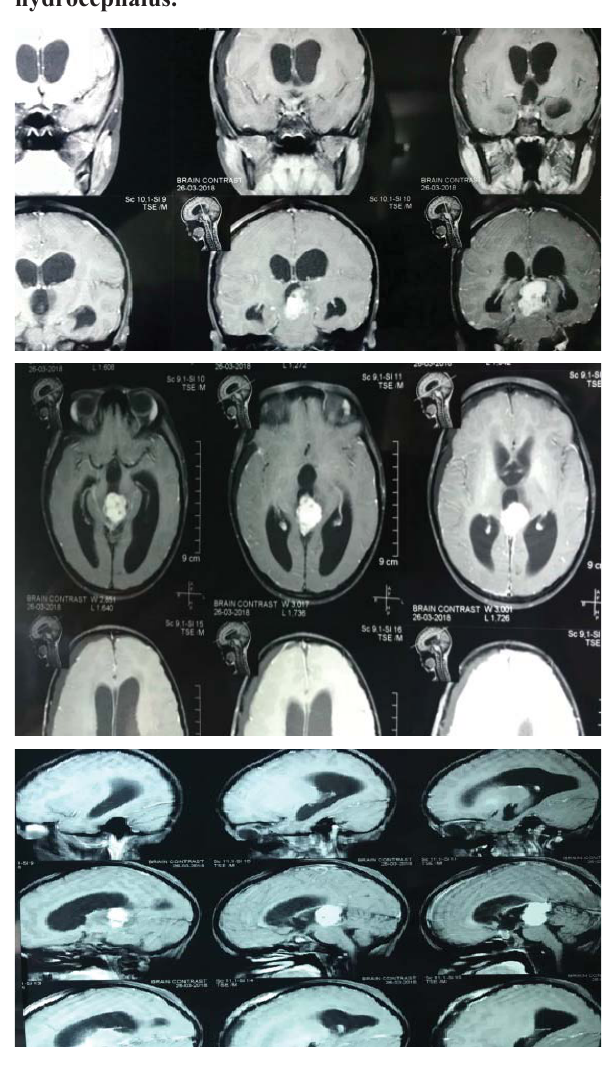
Figure 1. CT Scan shows hyperdense lesion in the posterior part of third ventricle associated with